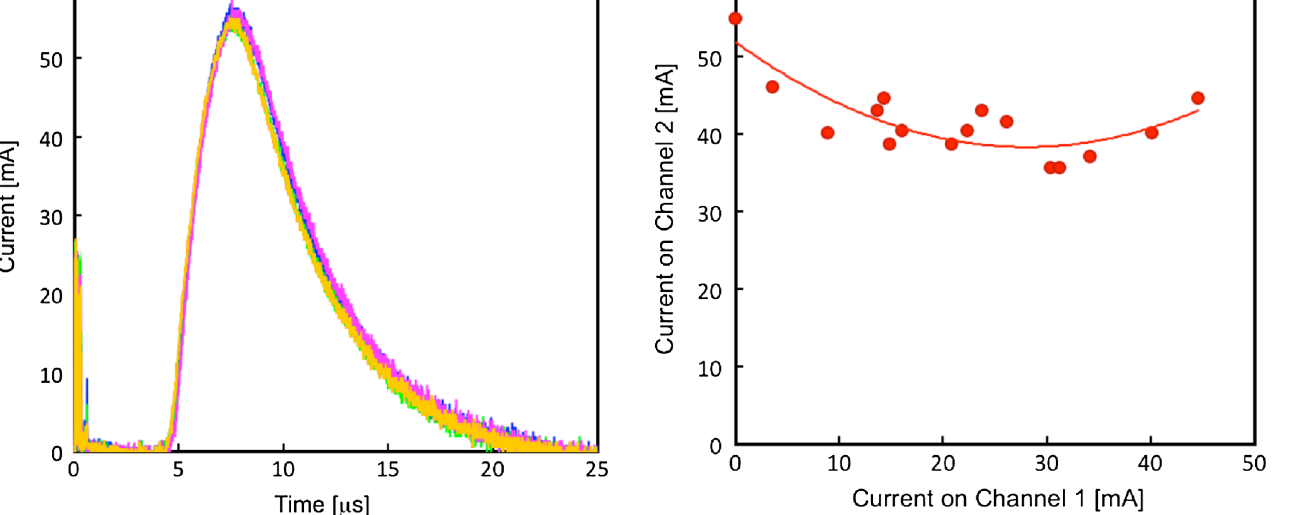
FIG. 40. Beam current waveform from channel 2 in single beam loading (pickup voltage: 5.2 V; plasma input position: 6 mm; extraction voltage: 30 kV). This graph is a superposition of the output beams in five laser shots.